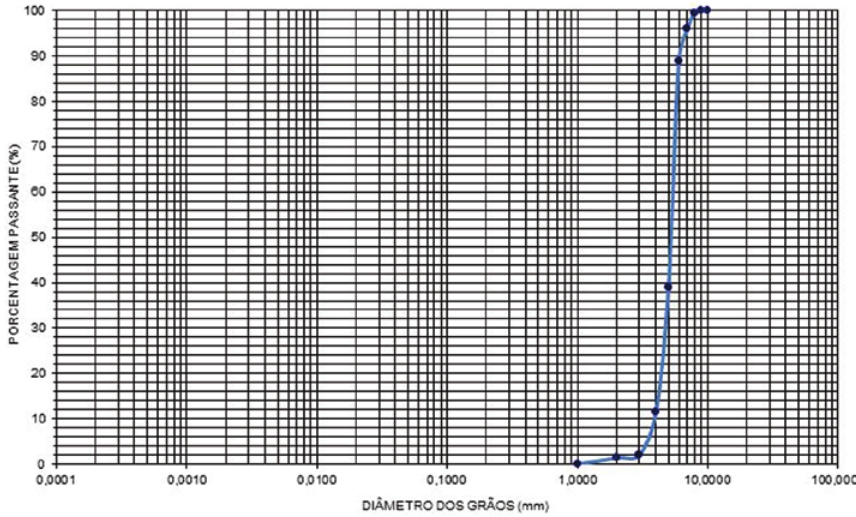
Granulometric curve – tire